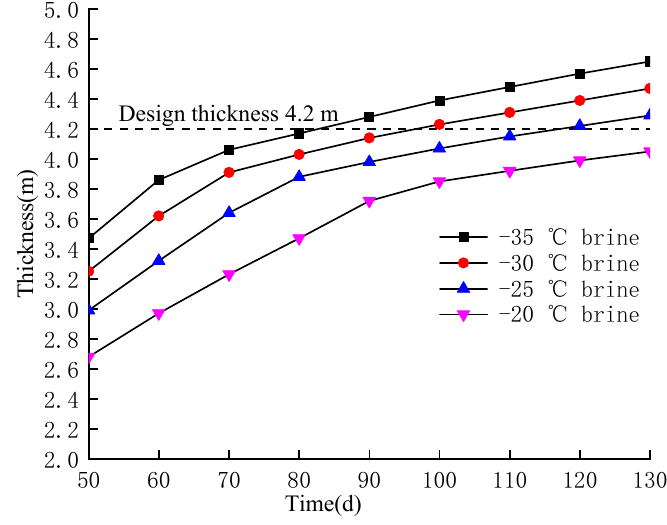
Figure 9. Variation in the thickness of effective frozen wall with time.